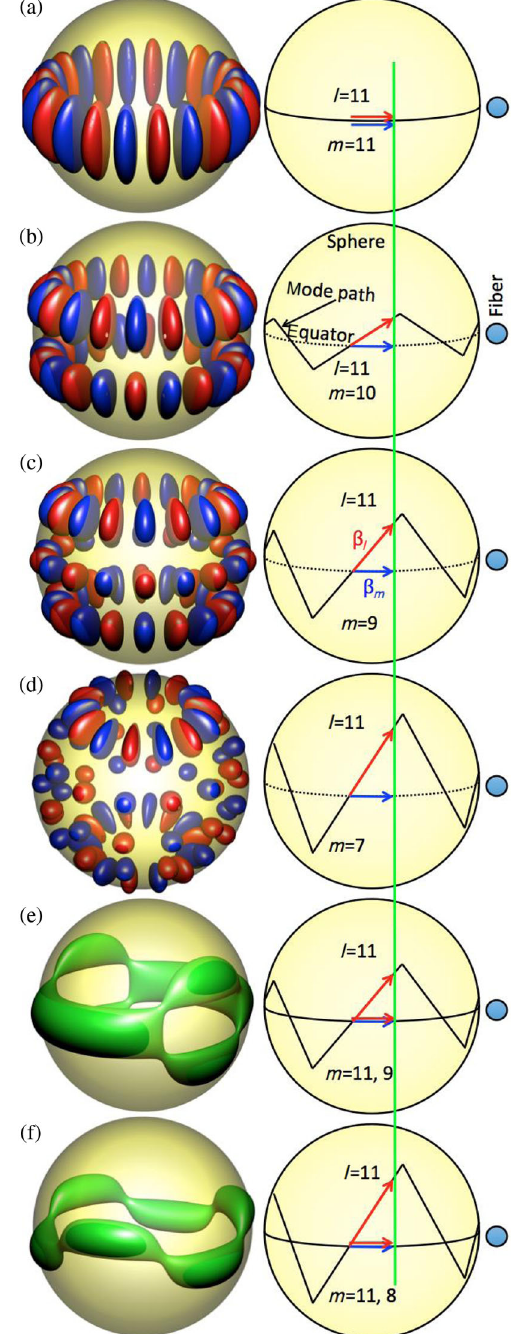
FIG. 1. Opticalmodesinsphericalresonators.(a)-(d)High-degree degeneracy in a spherical resonator where a family of modes have thesame propagation constant β m in thenet directionofpropagation (blue arrow), irrespective of their number of maxima between poles (here 1, 2, 3, and 5). (e),(f) Standing interference pattern generated by modes having the same resonance frequency, but with a different number of wavelengths along the equator ( m ). Red (blue) surfaces werecalculatedwithEq.(SM1)oftheSupplementalMaterial[25]to represent the location where the electric field falls to half of its maximum (minimum). Green represents an equal intensity surface. The polarization is TE, the radial number is 1, the refractive index is 1.4, and the sphere ’ s circumference is 11 optical